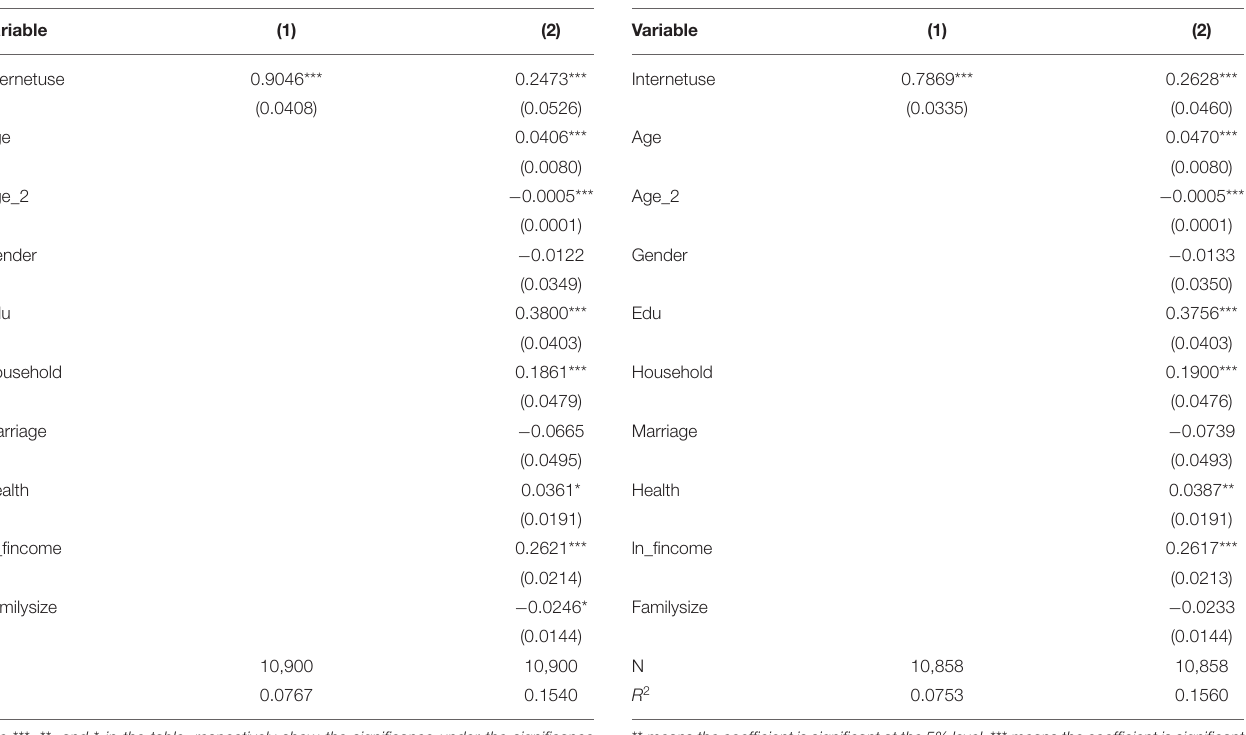
TABLE 3 | Benchmark regression. TABLE 4 | Robustness